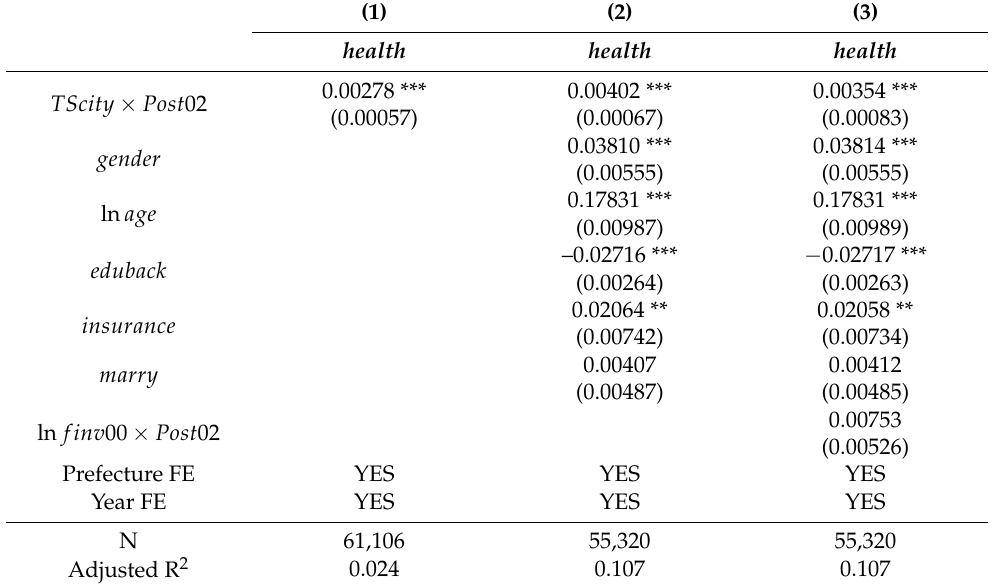
Table 2. Baseline specification